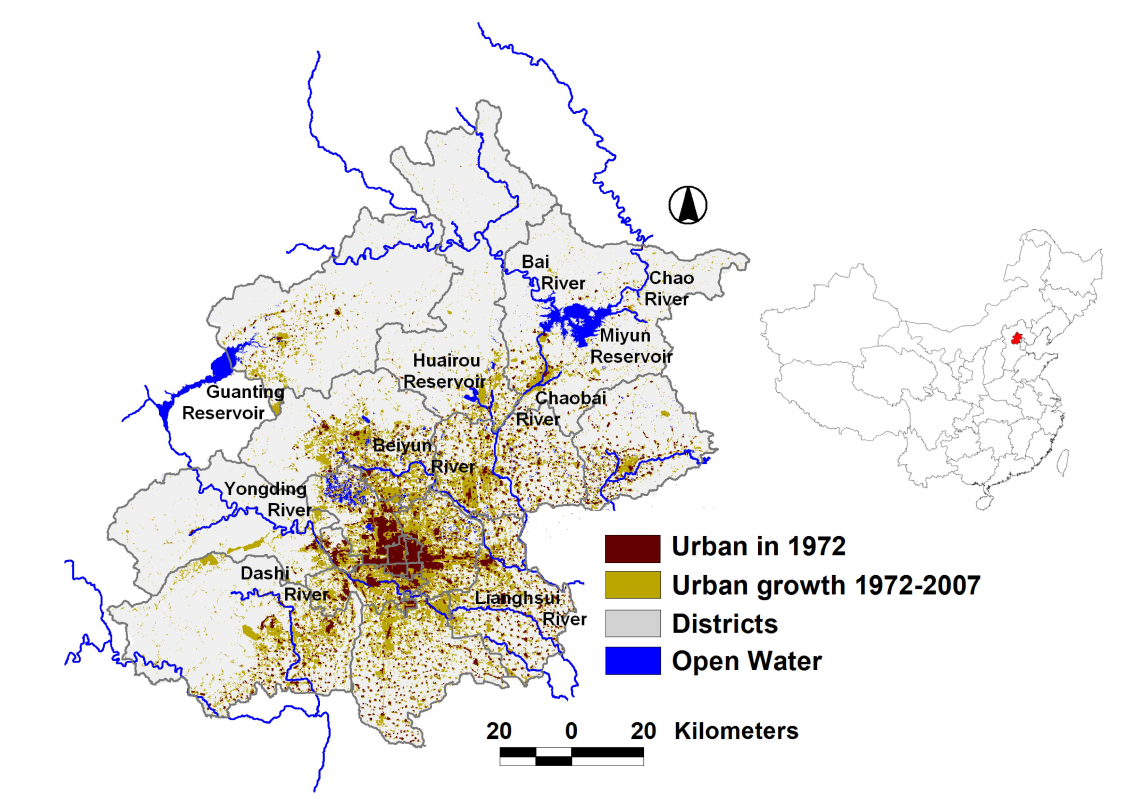
Fig. 2 . Map of Beijing with urban areas highlighted in 1972 and 2007, along with reservoirs, rivers, and lakes. Data from Li et al.